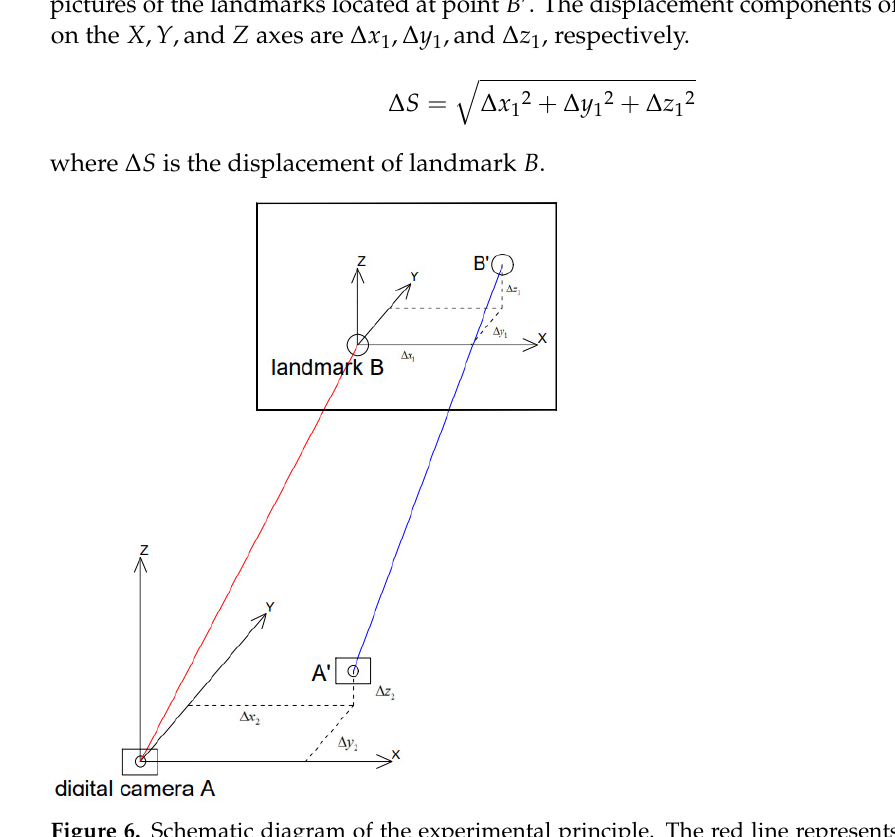
Figure 6. Schematic diagram of the experimental principle. The red line represents the shooting Angle before the digital camera and the landmark are moved. The blue line represents the shooting Angle after the digital camera and the mark point are moved.